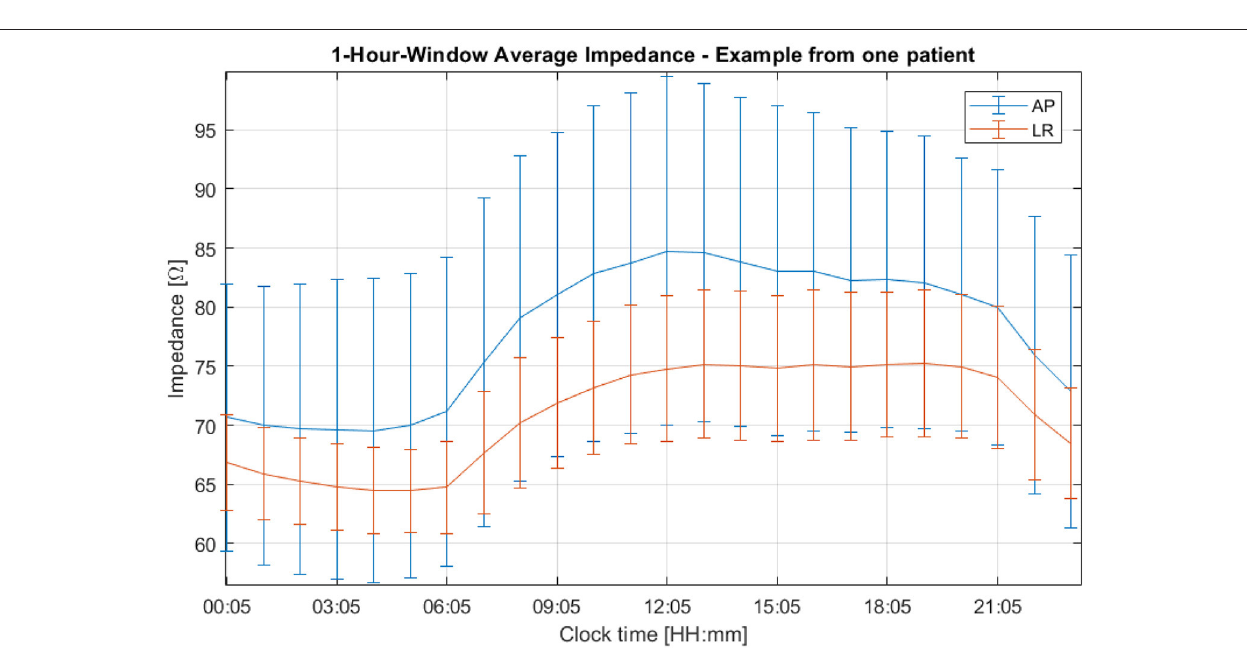
FIGURE 6 | One-hour averaged impedance as a function of the clock time for the AP (in blue) and LR (in orange) array pairs of one patient who participated in the EF-14 clinical trial. The vertical bars are representative of the variability of the data throughout treatment.